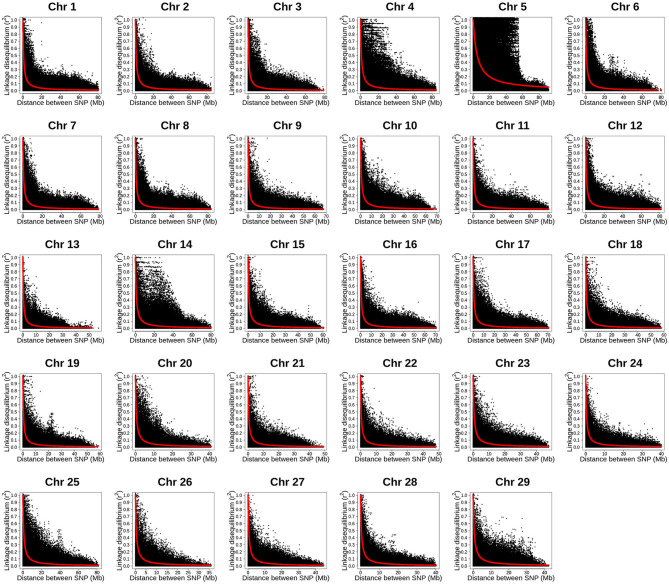
Linkage disequilibrium decay with physical distance estimated by chromosome using 34K SNP panel in year-class 2016 families from Clear Springs Foods, Inc. rainbow trout breeding population. For the LD analysis, in five replicates, one fish from each of the 100 YC 2016 families was randomly sampled with replacement; so, each genotype data set used for LD analysis included 100 unrelated fish. Here, we present results LD decay with physical distance from replication 5 (TIFF file).